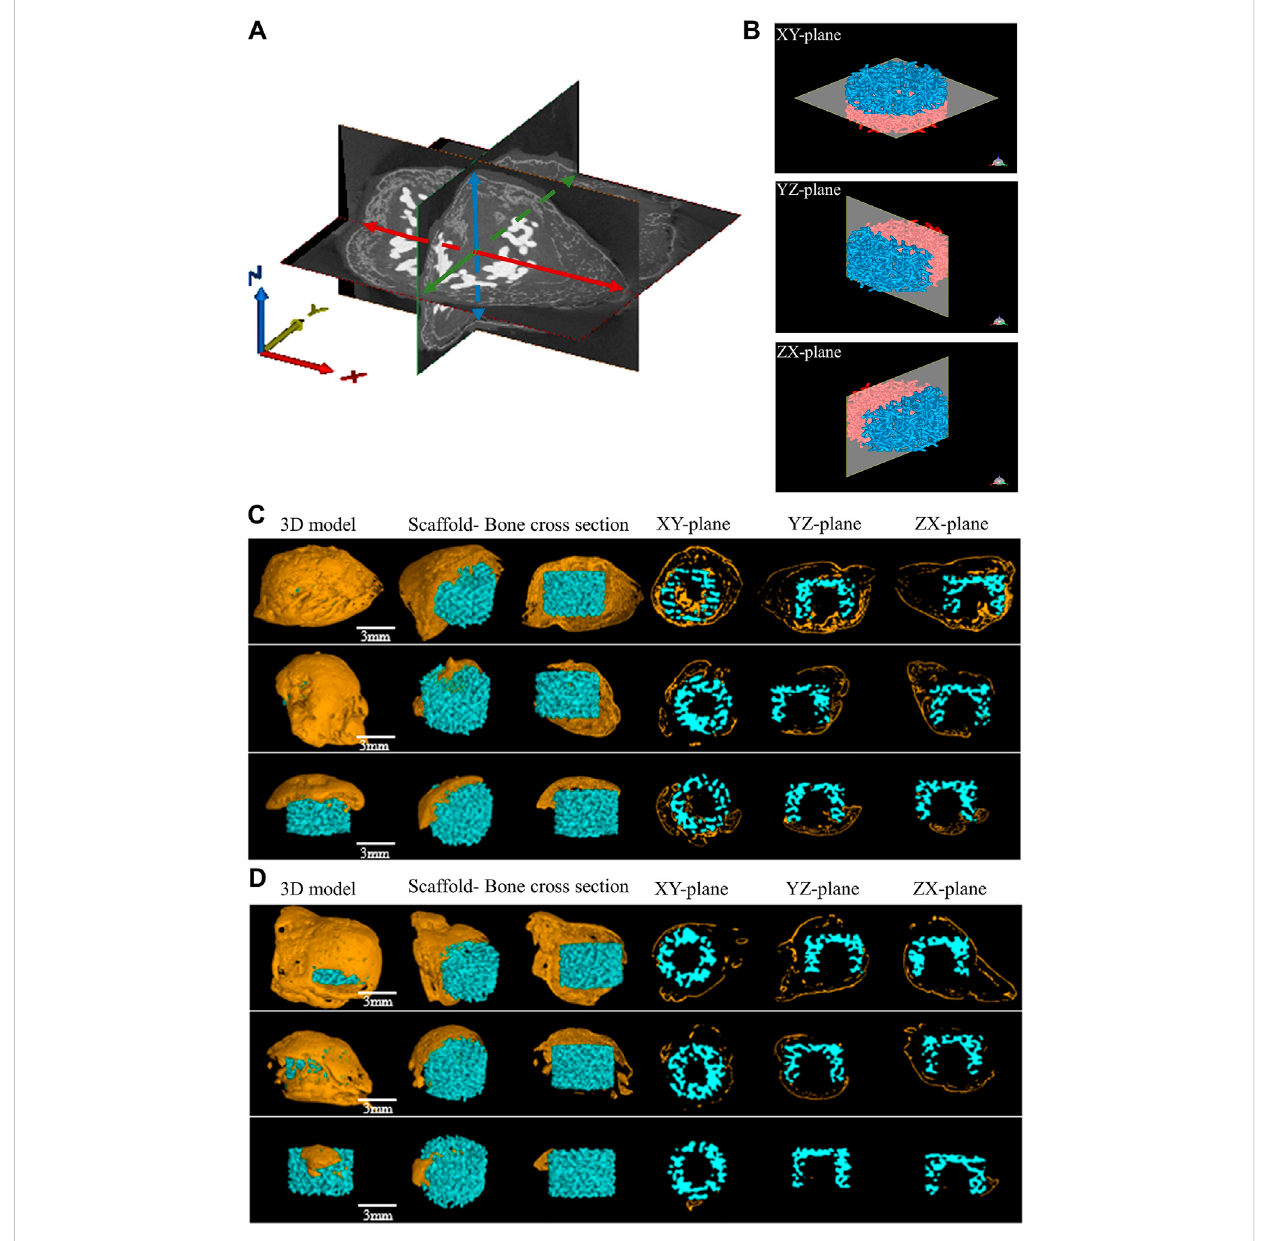
FIGURE 7 Micro-CT osteogenesis images of two experimental groups for 8 weeks (A) Schematic diagram of bone thickness measurement in different directions, red represents the maximum bone thickness obtained in the X -axis direction, green represents the maximum bone thickness obtained in the Y -axis direction, and blue represents the maximum bone thickness obtained in the Z -axis direction (B) Micro-CT analysis of bioceramic scaffolds from different planes (C) Micro-CT osteogenesis results in the “ Scaffold + SCAPs + BMP9 ” group (D) Micro-CT osteogenesis results in the “ Scaffold + SCAPs + BMP9+VEGF ”